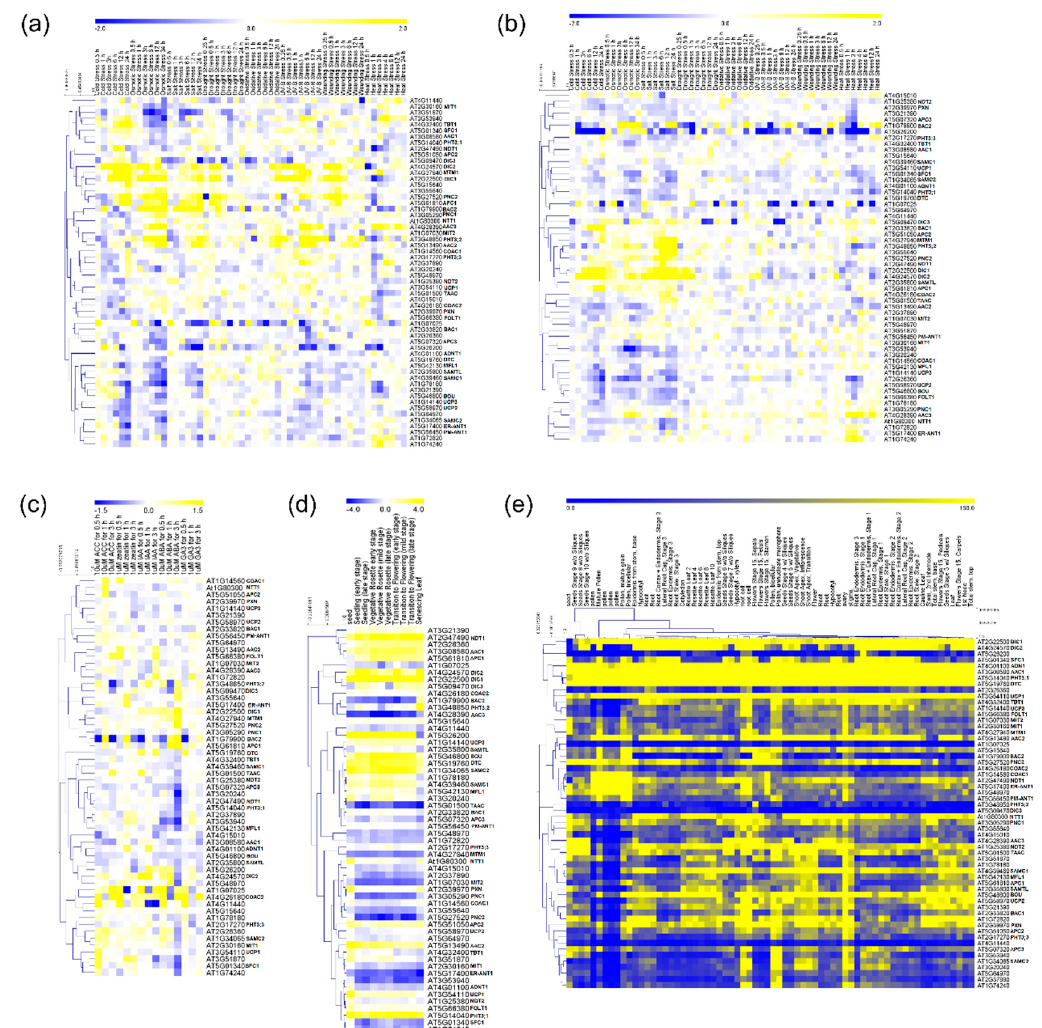
Figure 1. Hierarchical cluster of gene expression analysis of mitochondrial carrier family (MCF) genes of Arabidopsis thaliana . Heat map of MCF genes in shoots ( a ) and roots ( b ) of plants under a range of stress situations. Heat map of MCF genes expression in plants submitted to hormone treatment ( c ), throughout plant development ( d ) and in several tissues ( e ). The values are stated as log2 ratio ( a – d ) and relative value ( e ). The complete data set is presented in the supplemental information online (Supplementary File S1). For definitions of gene names, please see the main text.